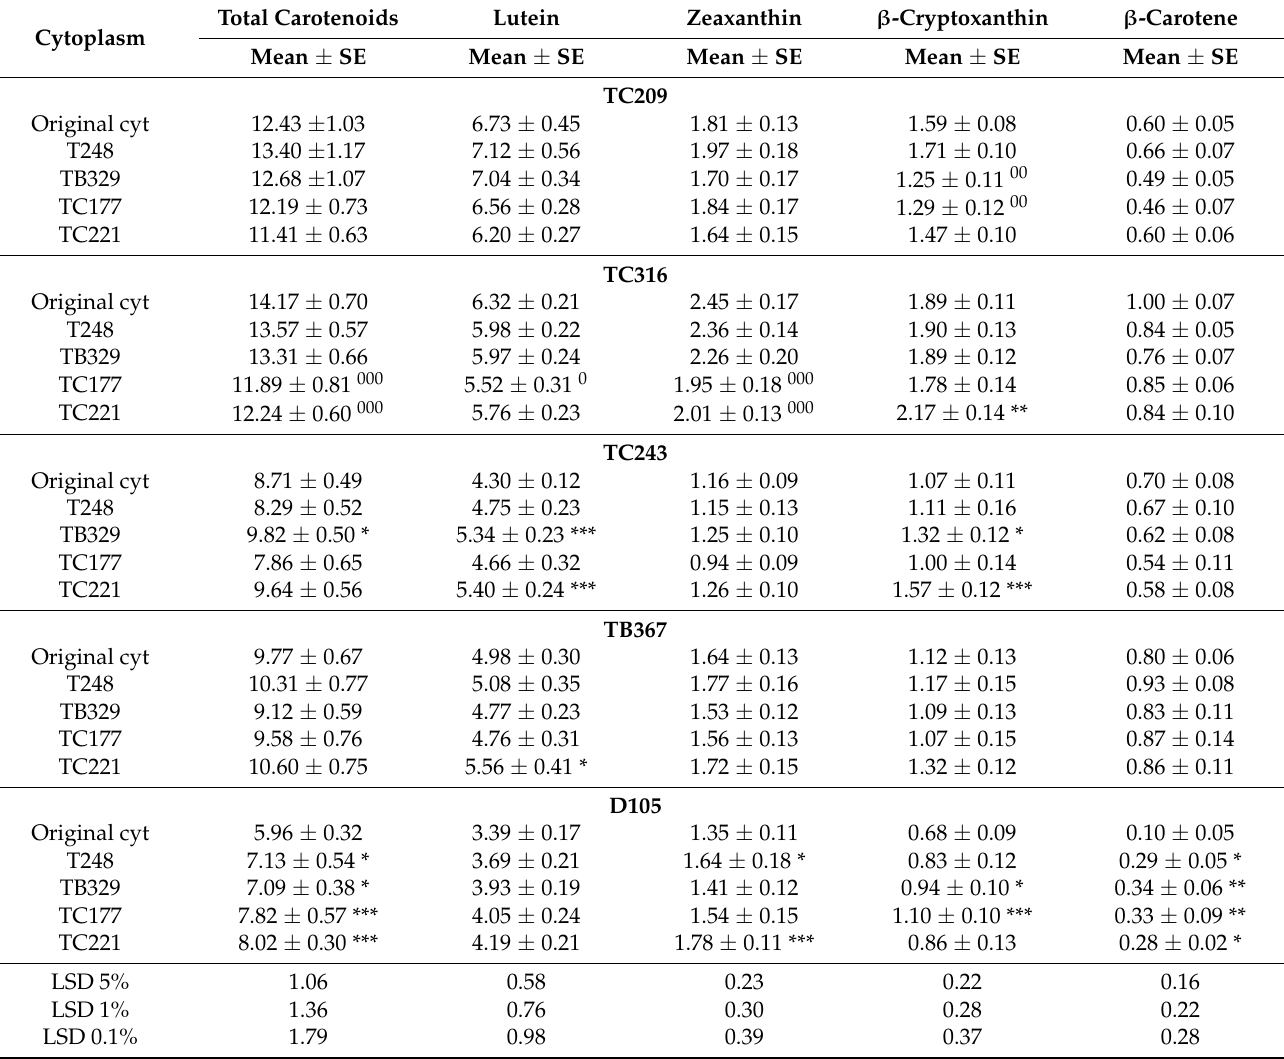
Table 5. The influence of cytoplasm × nucleus interaction on the carotenoid content of the hybrids ( µ g/g)—ANOVA